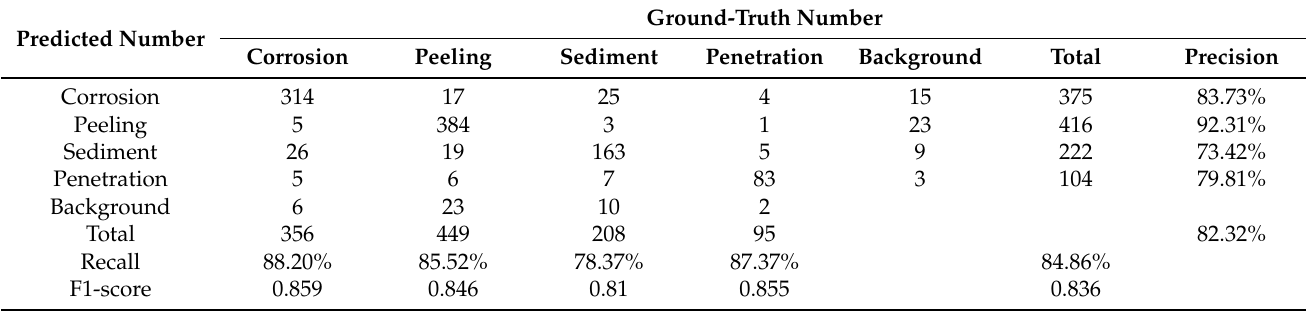
Table 4. Defect detection result based on original